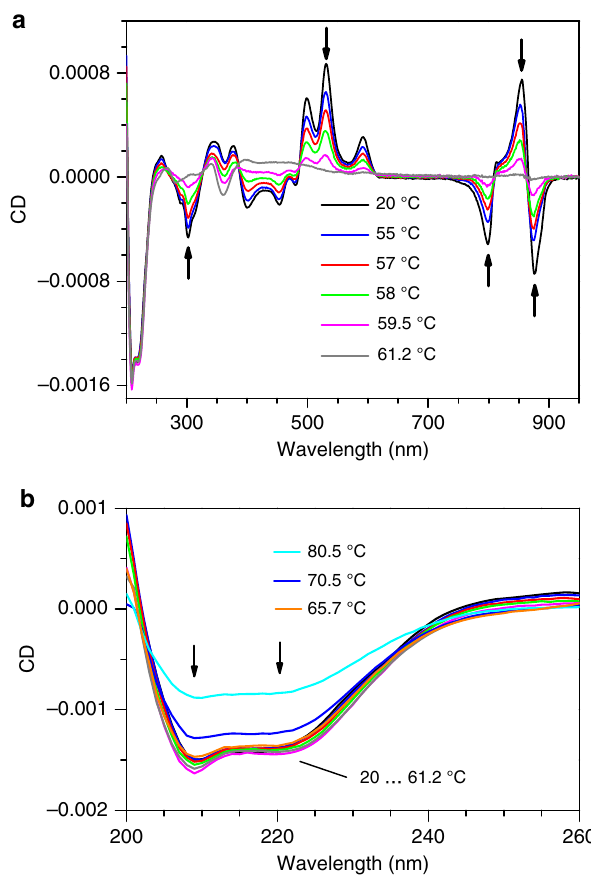
Fig. 2 Temperature dependence of CD spectra. a CD spectra of the LH2 complex from R. acidophilus at different temperatures. The initial optical density of the sample in 1 mm cuvette at 858 nm was 0.58. b The zoomed- in protein region of the CD spectra. Arrows indicate the lines selected for presentation in Fig.